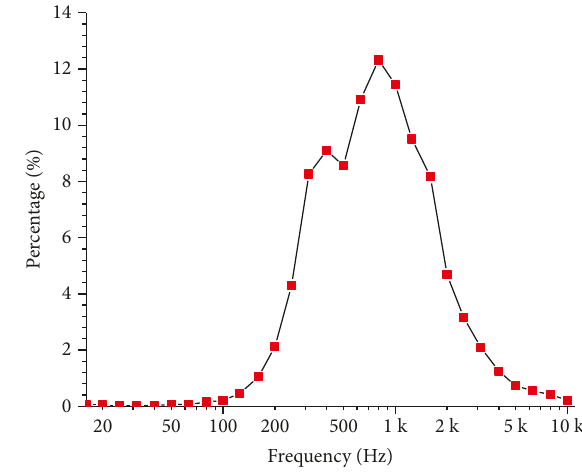
Figure 17: Percentage curve for the sound source energy at each frequency band on the bottom of the head car ’ s streamlined part (component 8, free fl ow speed: 83